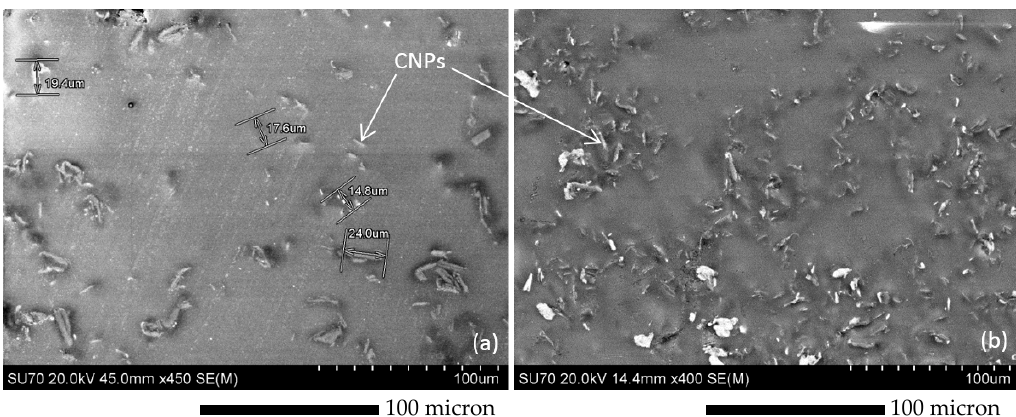
Figure 2. SEM images of ( a ) 2 wt % and ( b ) 5 wt % CNP filled epoxy specimens, showing relatively long rod shape nanoclusters in 2 wt % specimens (~20 micron long) as opposed to relatively short and agglomerated nanoclusters in 5 wt % specimens (~10 micron long).